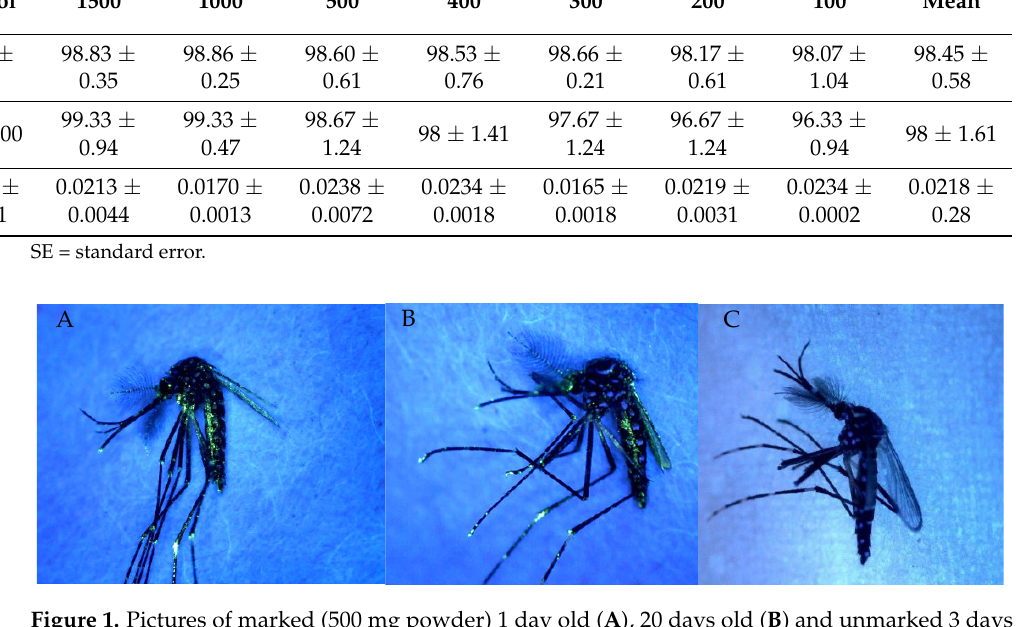
Table 1. Emergence rate and efficacy of the self-marking method as a function of the quantity of fluorescent powder applied to surface water.